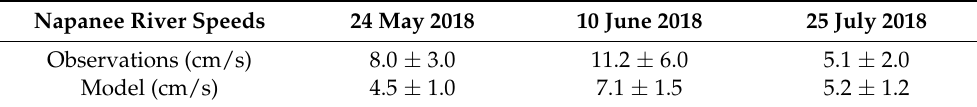
Table 2. Comparison of observed drifter speeds in the Napanee River to model speeds.